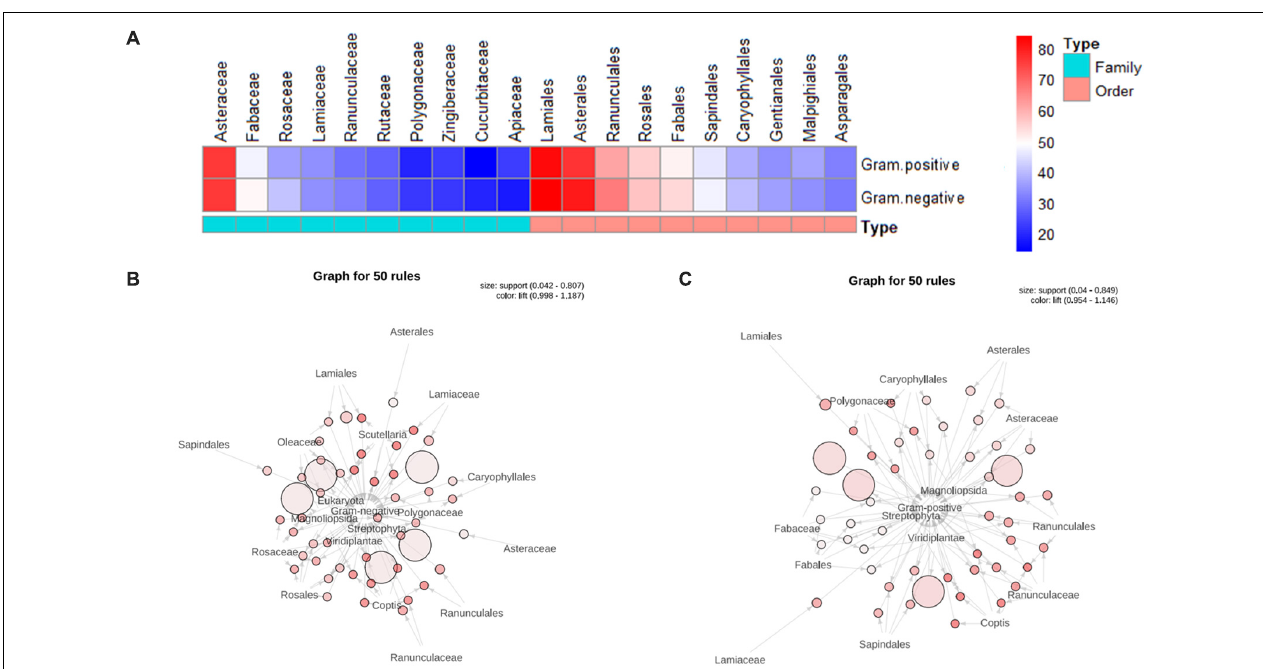
FIGURE 4 | Distribution law of antibacterial TCMs families. (A) Heatmap of antibacterial TCMs orders and families frequency (TOP 10). (B) The association network of TCMs families against gram-negative bacteria. (C) The association network of TCMs families against gram-positive bacteria. Note: the circle in the figure represents association rules. The size of the circle represents the degree of support, the larger the circle, the greater the degree of support. The color of the circle represents the degree of confidence, the darker the color, the greater the degree of confidence. The arrow indicates the relationship between two things. The side pointing to the circle is the antecedent of the rule, and the side pointed out from the circle is the consequent of the